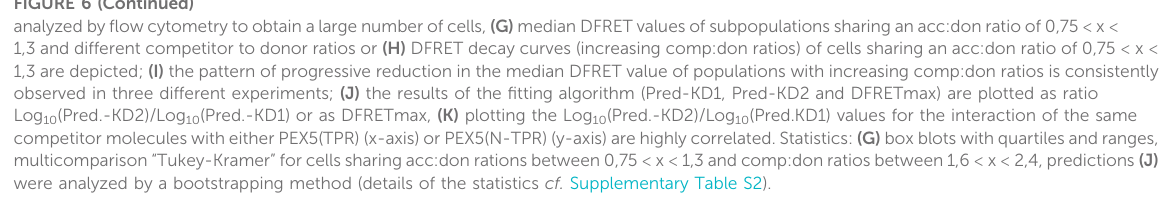
(Figure 7B). The apparent interaction strength KD1 app obtained by bimolecular fi tting was in the same range as PTS1 motifs (~5.0E4 a. u.). Moreover, we demonstrated that overexpression of Cerulean-PTS1 (ACOX3) did not change the apparent interaction strength between PEX14(NTD) and PEX5(N-TPR), as overexpression of Cerulean-PTS1(ACOX1) did not affect the shape of the saturation curve (Figure 7C) and the comp:don dose response curve was fl at (Figure 7D), a pattern, which was consistently found in three independent experiments (Figures 7E,F). This suggests that cargo-binding of PEX5(N-TPR) is not prerequisite for the interaction between PEX5(N-TPR) and